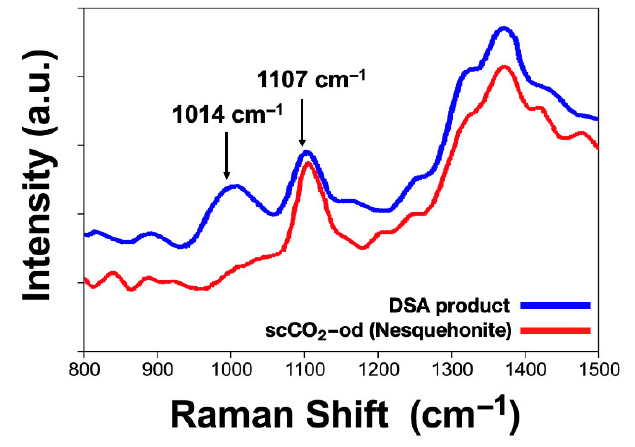
Figure 5. Raman spectra of the DSA product (aqueous route, blue curve, above) and scCO 2 -od (nesquehonite, supercritical route, red curve), acquired with a 785 nm laser, 5 s acquisition time. For comparison, Figure 6 shows the Raman spectrum of the scCO 2 -hpd material, which only shows the characteristic peak of the symmetric stretching of the carbonate ion at 1100 cm − 1 [26].